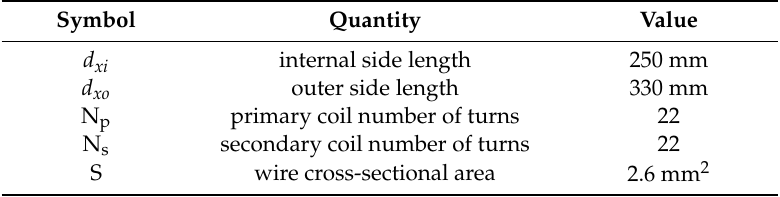
Table 1. Parameters for the square coil.